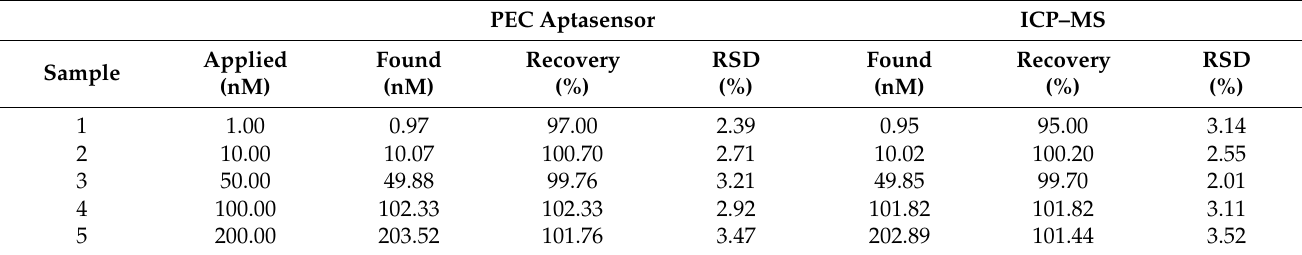
Table 1. Determination of DCF in river water samples based on the constructed PEC sensing